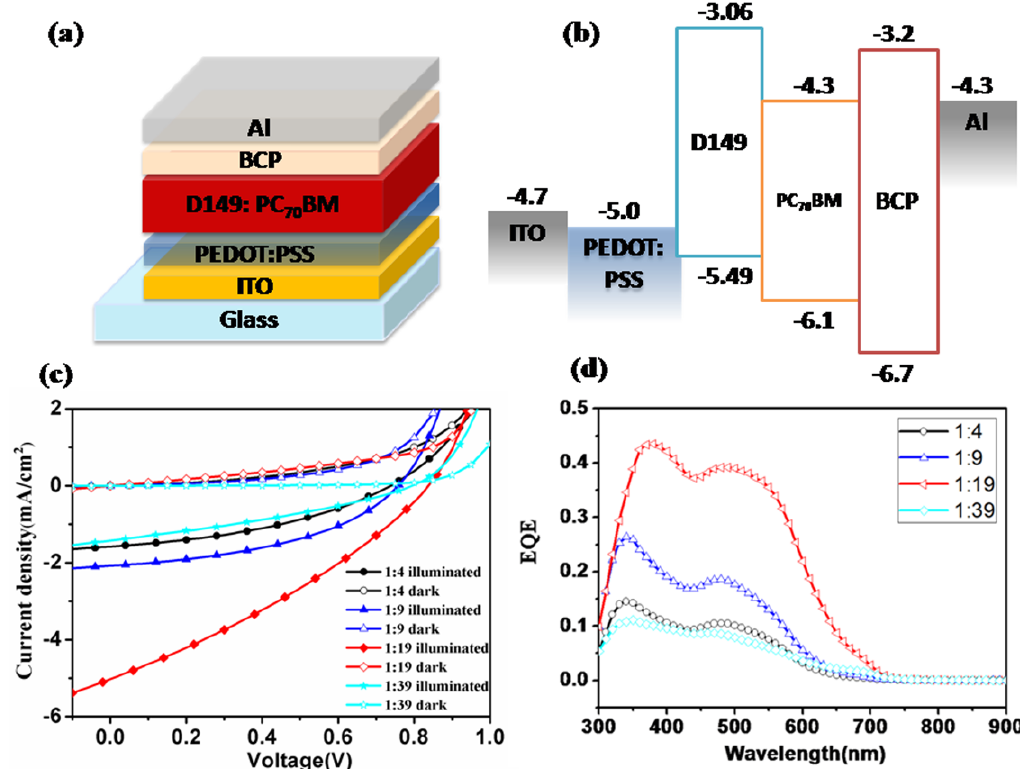
2. ( a ) Device architecture of BHJ solar cell, ITO/PEDOT: PSS/D149: BM/BCP/Al; ( b ) Energy level alignment within the BHJ device; ( c ) J-V curves of the PC 70 BHJ solar cell with different blending ratios (w/w) of D149: PC the corresponding BHJ